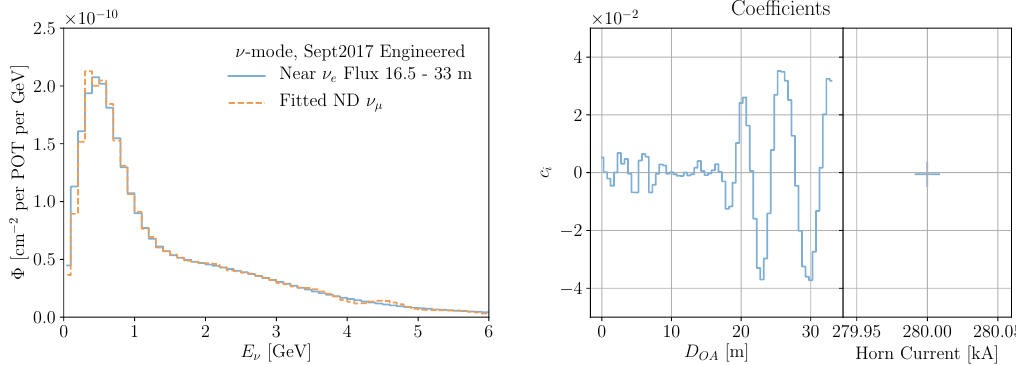
Figure 108. ( Left ): the matching of ND off-axis ν µ fluxes to the average ND intrinsic ν e flux between 16.5 and 33 m is shown. ( Right ): the linear combination coefficients used for the fitted flux on the ( left